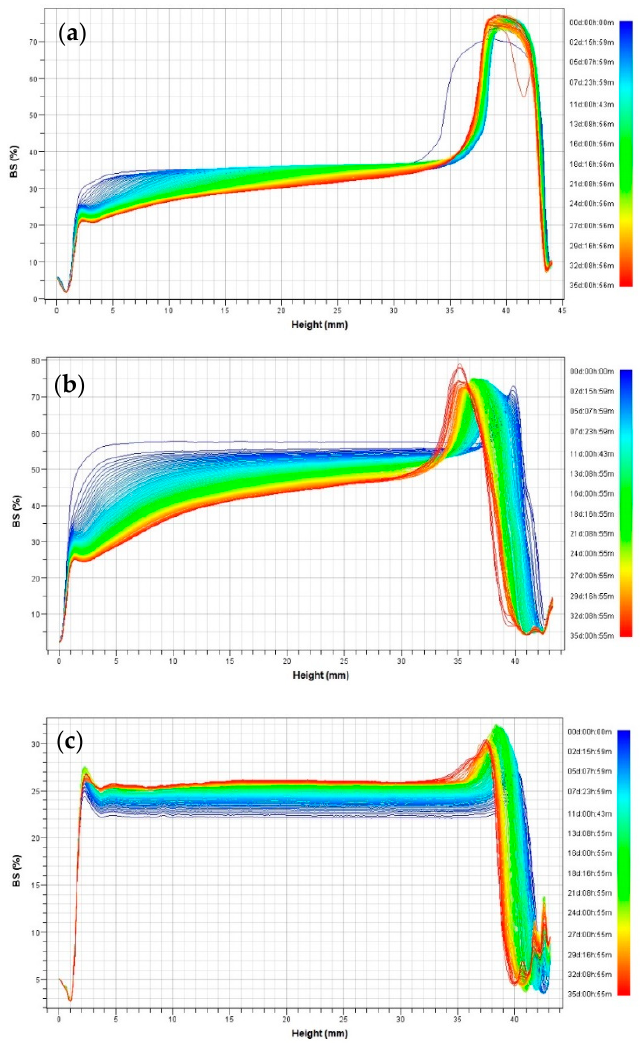
Figure 4. Backscattering profiles of W/O/W emulsions (optimal formulations) prepared by three devices through 35 days of storage at 25 ° C: ( a ) Rotor-stator mixer; ( b ) Ultrasonic homogenizer; ( c ) Microfluidizer processor.